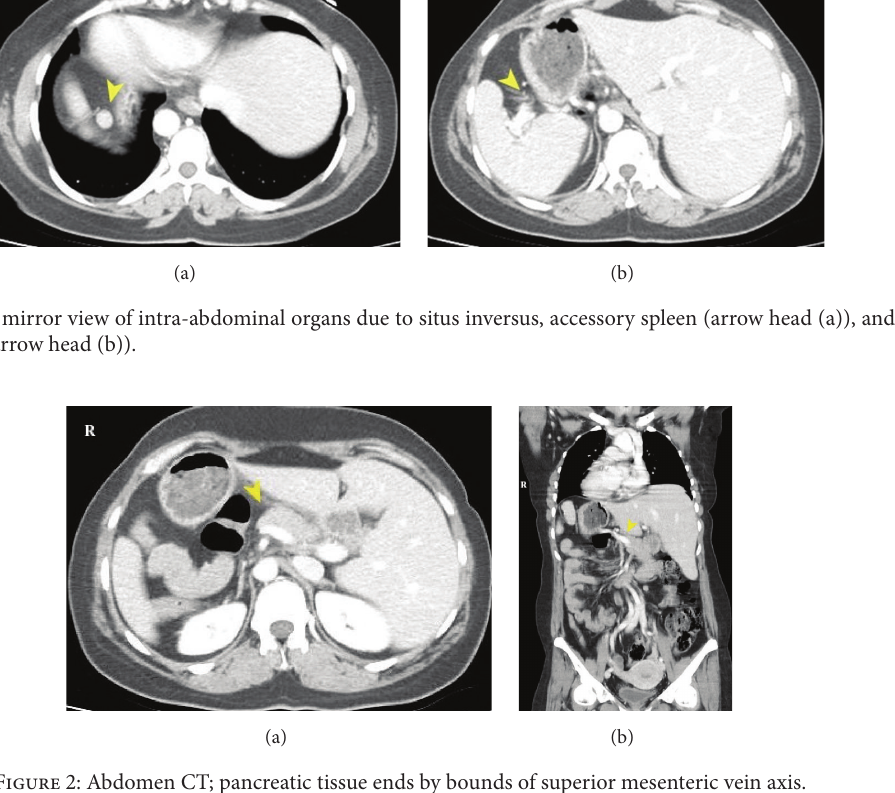
Figure 2: Abdomen CT; pancreatic tissue ends by bounds of superior mesenteric vein axis.